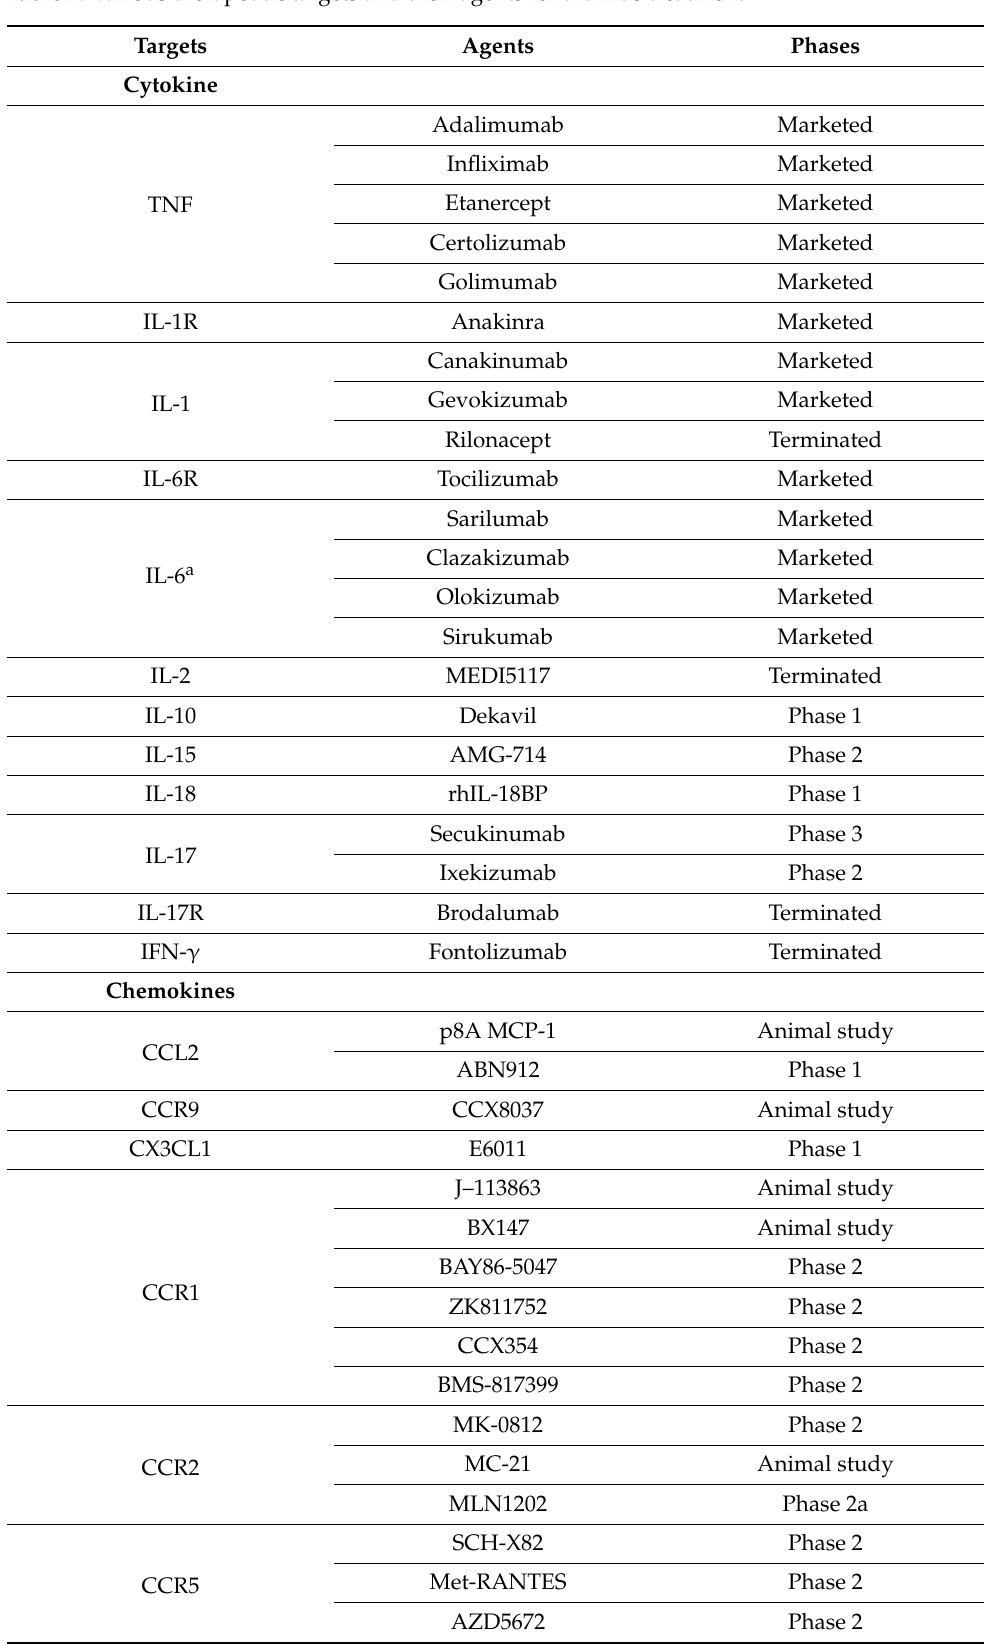
Table 1. Various therapeutic targets and their agents for arthritis